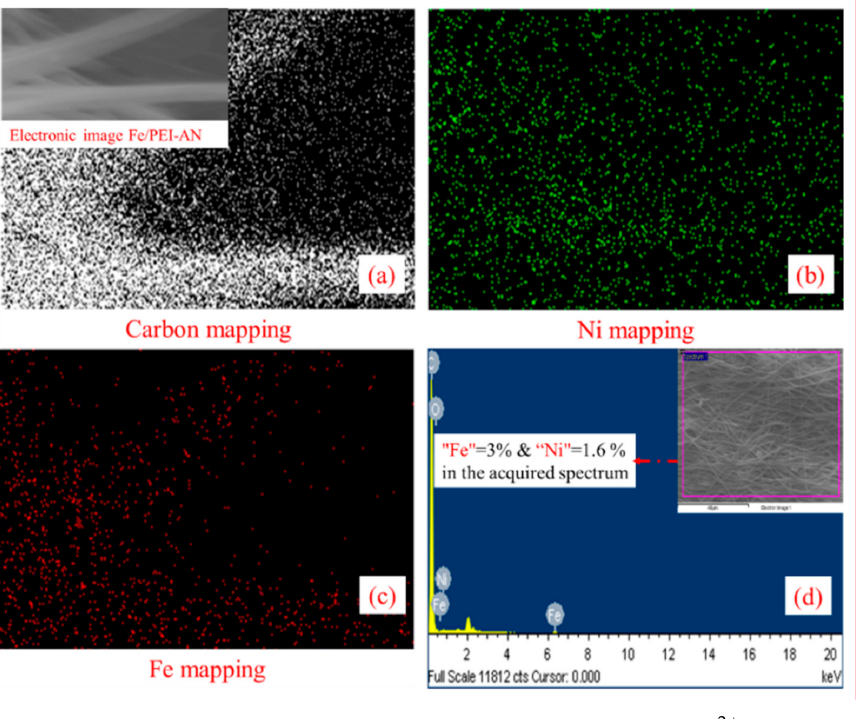
Figure 8. ( a – c ) EDX mapping and ( d ) EDX spectra of Fe/PEI-AN after Ni 2 + adsorption.